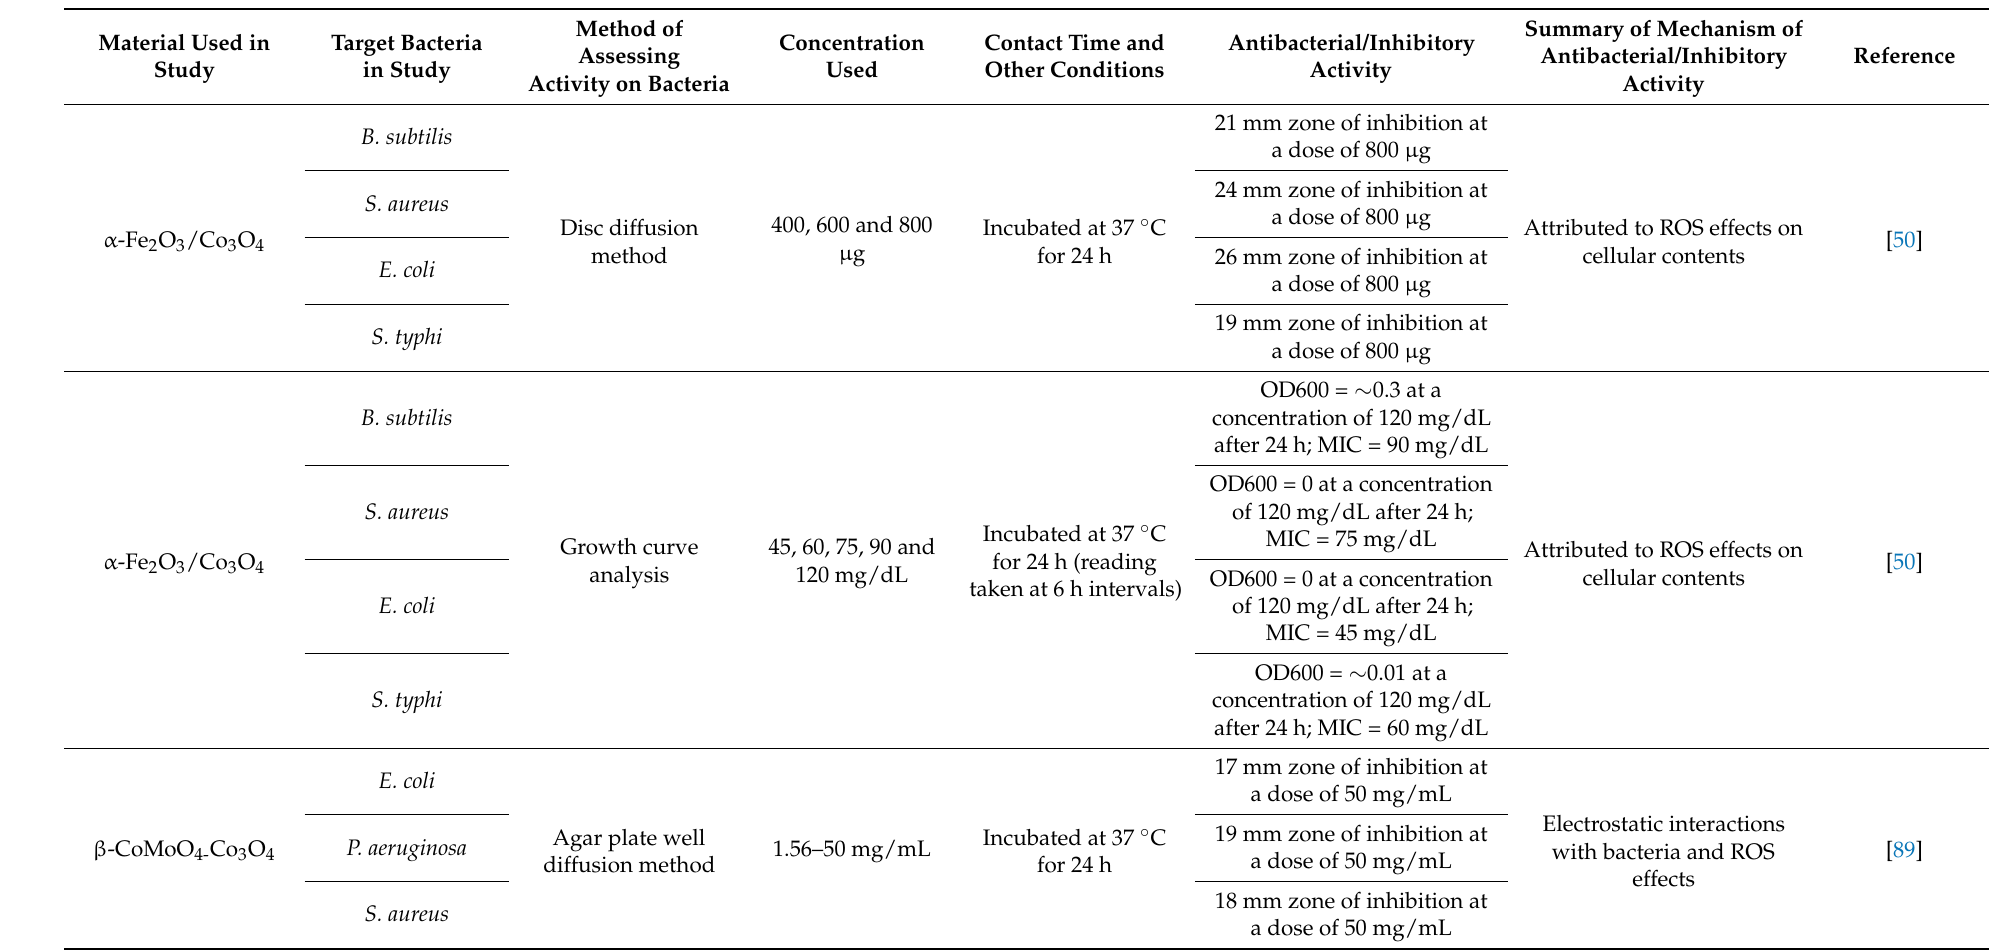
Table 4. Cobalt oxide nanocomposites or other cobalt oxide based nanoparticles and bacteria remediation